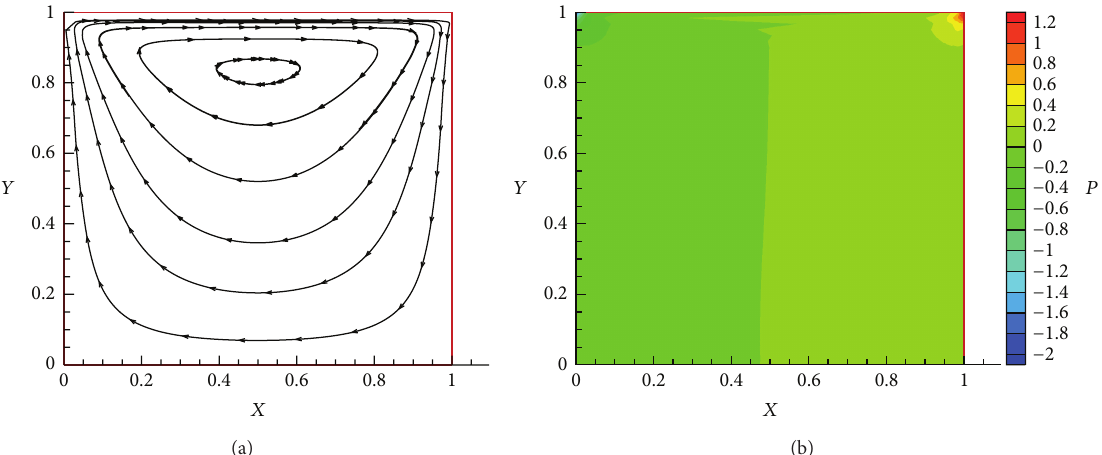
Figure 4: Velocity streamlines (a) and pressure level lines (b) for the local Gauss integration method with 𝜀 = 1.0𝑒 − 6 , 𝛼 = 100 , and 𝑟 = 4 , respectively.